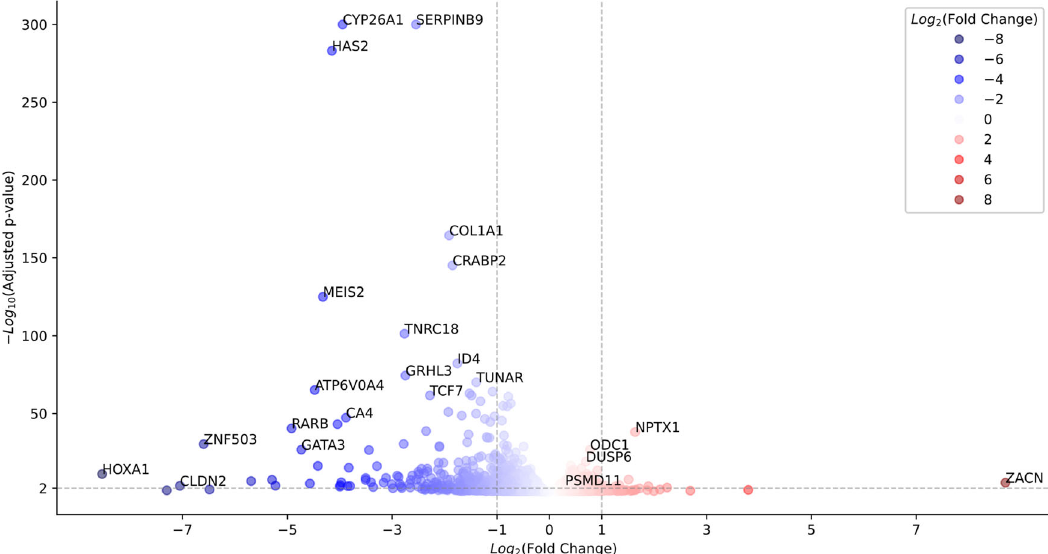
Fig. 5 Volcano plot of differential gene expression between hPSCs cultured in simulated microgravity (sµg) and 1g condition. The color intensity is proportional to Log2 (Fold Change). Genes are overly expressed under sµg condition if Log2 (Fold Change) > 0 (colored red in the fi gure). The vertical dashed lines correspond to Log2 (Fold Change) = ±1, and the horizontal line corresponds to the adjusted p -value = 0.01. There are a few genes that are highly expressed under 1g conditions such as HAS2, CYP26A1, SERPINB9,